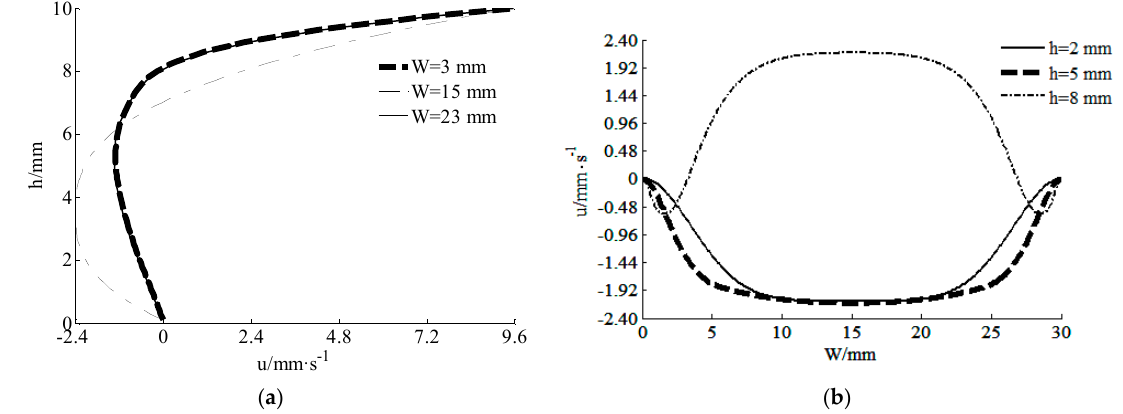
Figure 3. Distributions of the velocity component u at different directions: ( a ) velocity u -depth h , and ( b ) width W -velocity u